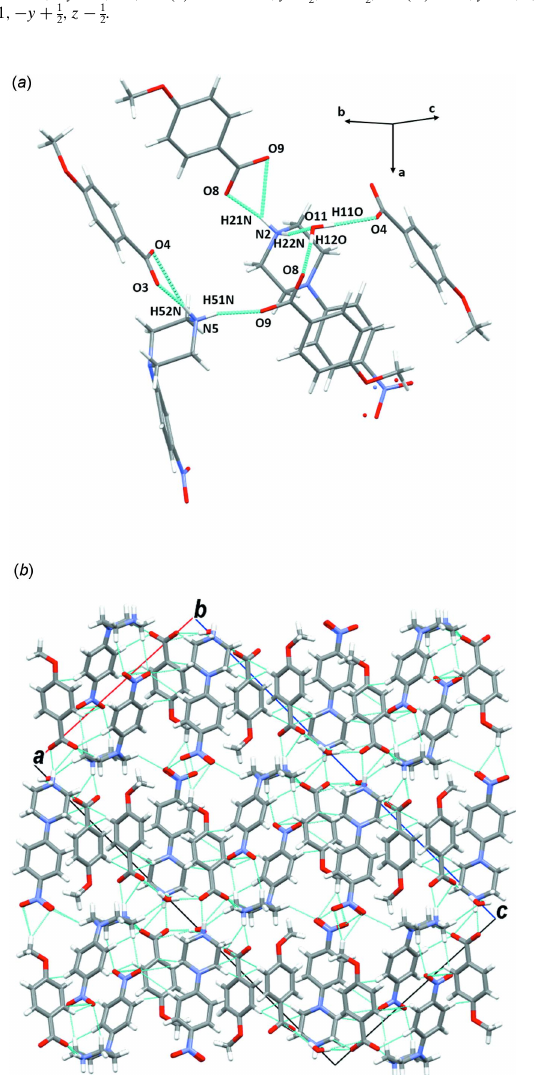
Figure 12 ( a ) A general view of the main intermolecular interactions (N—H (cid:2)(cid:2)(cid:2) O,